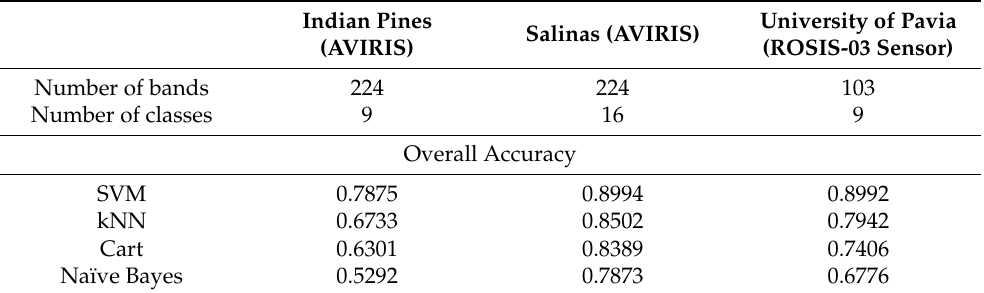
Table 11. Overall accuracy of support vector machines (SVM), k-nearest neighbors (kNN), classifica- tion and regression trees (Cart), and naïve Bayes on three different